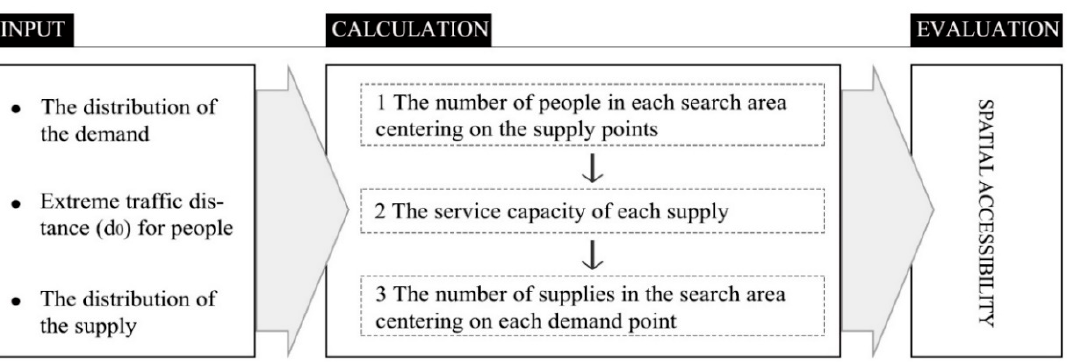
Figure 2. Principle of the two-step floating catchment area (2SFCA) model.